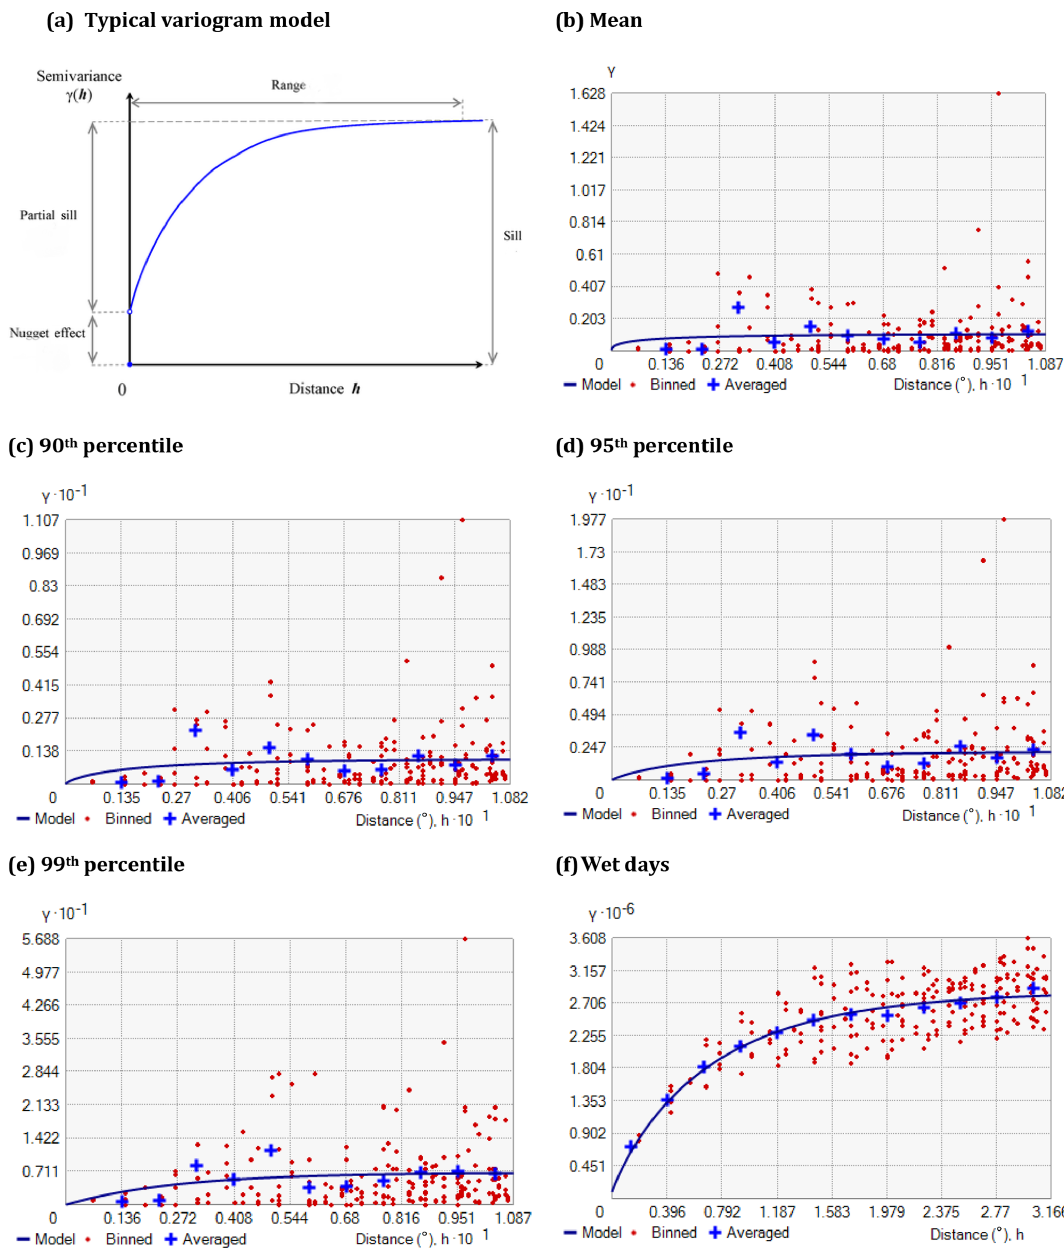
Figure B1. Typical variogram model (a) and fitted variogram models for the daily mean (b) , 90th (c) , 95th (d) , and 99th (e) percentile precipitation, and number of wet days (f)